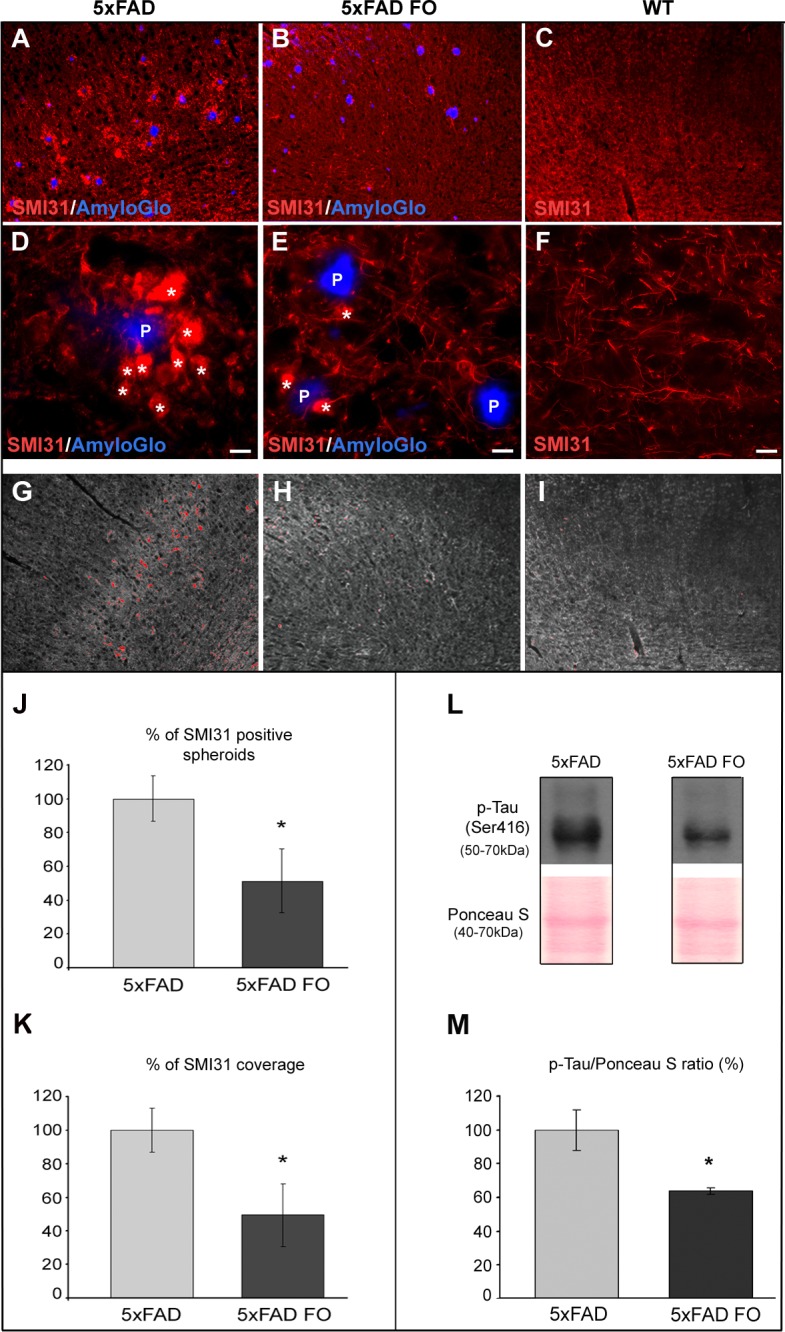
FO supplementation ameliorates neuritic dystrophy through suppression of abnormal tau hyperphosphorilation in the parietal cortex of 5xFAD mice.(A and D) Axonal dystrophies (arrows) surrounding amyloid plaques (P) in 4-month-old 5xFAD mice; (B and E) Brains of FO-supplemented 5xFAD mice showing significant suppression of dystrophic axons around plaques; (C and F) wild type mice showing absence of dystrophic neurites (G-I) Print screen of ImageJ SMI31 analysis (Max Entropy threshold). (J) Percentage of SMI31-positive spheroids larger than 50μm2 in untreated and FO-treated 5xFAD mice. (K) Percentage of SMI31 coverage of parietal cortex in untreated and FO-treated 5xFAD mice (low surface area limit set to 50μm2). (L) Representative immunoblot of p-Tau (Ser416) in untreated and FO-treated 5xFAD mice. (M) Changes in p-Tau (Ser416) protein in the cortex of 5xFAD and 5xFAD FO mice were revealed by Western blot analysis. The data represent mean ± S.E.M. value; *p < 0.05. Scale bar (D-F) - 5μm.